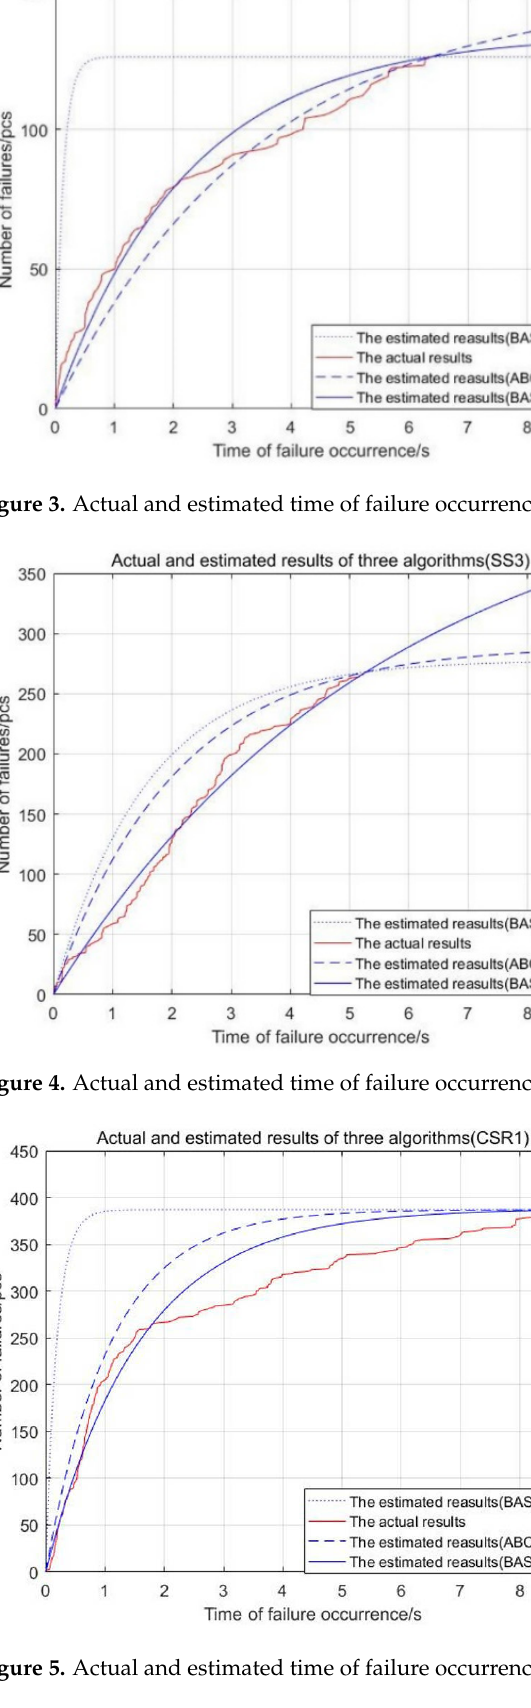
Figure 6. Actual and estimated time of failure occurrence of three algorithms (CSR2).